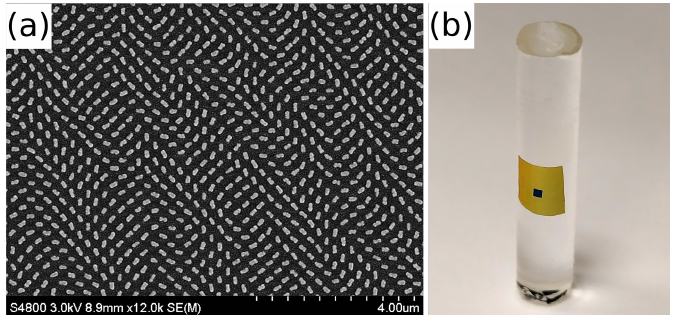
Figure 2. ( a ) The nanorods comprising the MS and imaged with SEM after the membrane was lifted from the rigid initial substrate; ( b ) An experimental image displaying an MS conformed to a nonflat surface. The central patterned area appears darker due to the reduced reflectivity with respect to the surrounding